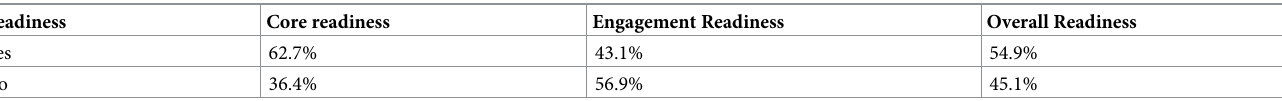
Table 2. Overall, core and engagement readiness